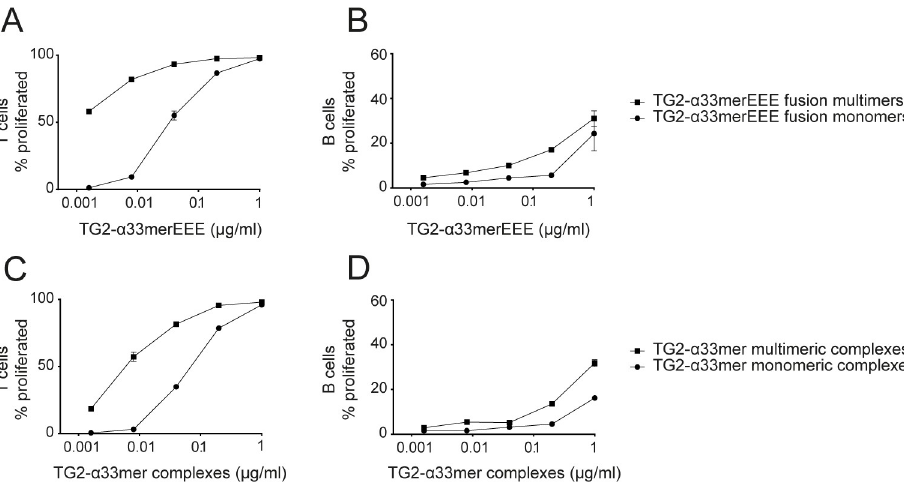
Fig 2. TG2-gluten multimers are superior to monomers at activating gluten-specific T cells and TG2-specific B cells. B cells isolated from Tgm2 -/- DQ2.5.14E06 mice and CD4 + T cells isolated from DQ2.5.TCR-glia- α 2 mice were labeled with different proliferation-tracking dyes and co-cultured in vitro for three days stimulated with indicated antigens. (A,B) Dose response curve of proliferative response to TG2- α 33merEEE fusion monomers and multimers for CD4 + T cells (A) and B cells (B). (C,D) Dose response curve of proliferative response to TG2- α 33mer monomers and multimers for CD4 + T cells (C) and B cells (D). Graphs report proliferation as % proliferated when gated on dye- labeled CD4 + or B220 + cells. Points and bars represent mean +/- SEM. Data is representative of three independent experiments set in